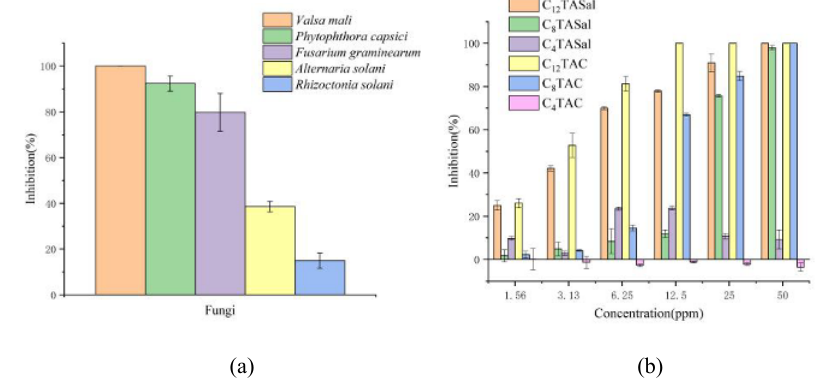
Fig. 2. (a)Antifungal activity screening of C 12 TAC; (b) SAR of different